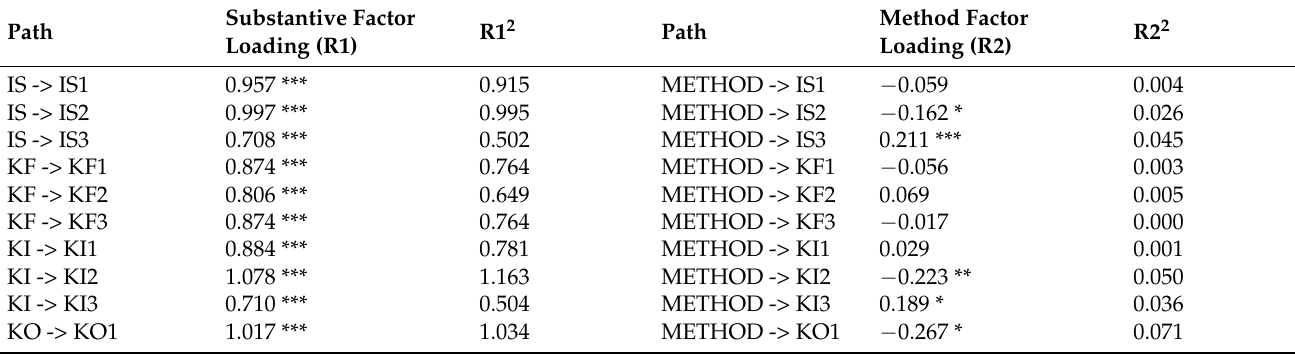
Table 3. Common method bias